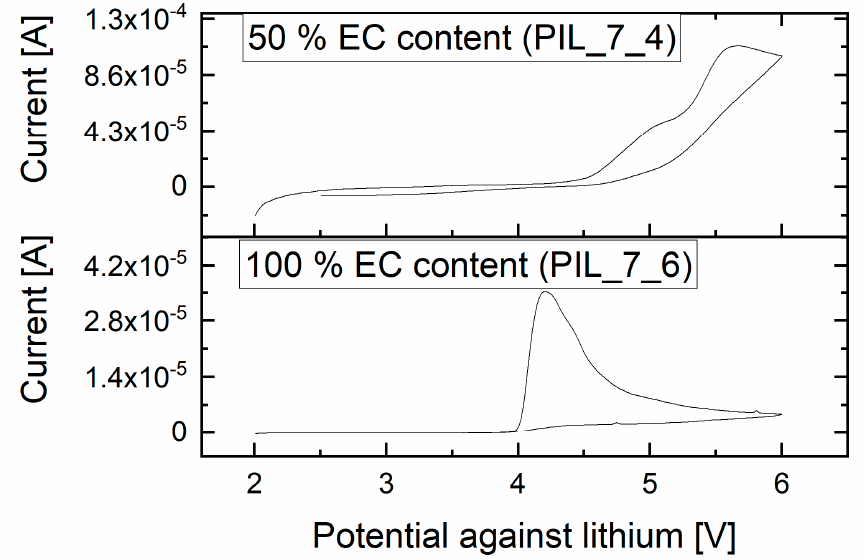
Figure 8. Results of the cyclic voltammetry measurements of the polymer electrolyte membranes on aluminum foil against metallic lithium at 25 °C and 1 mV·s − 1 feed rate.